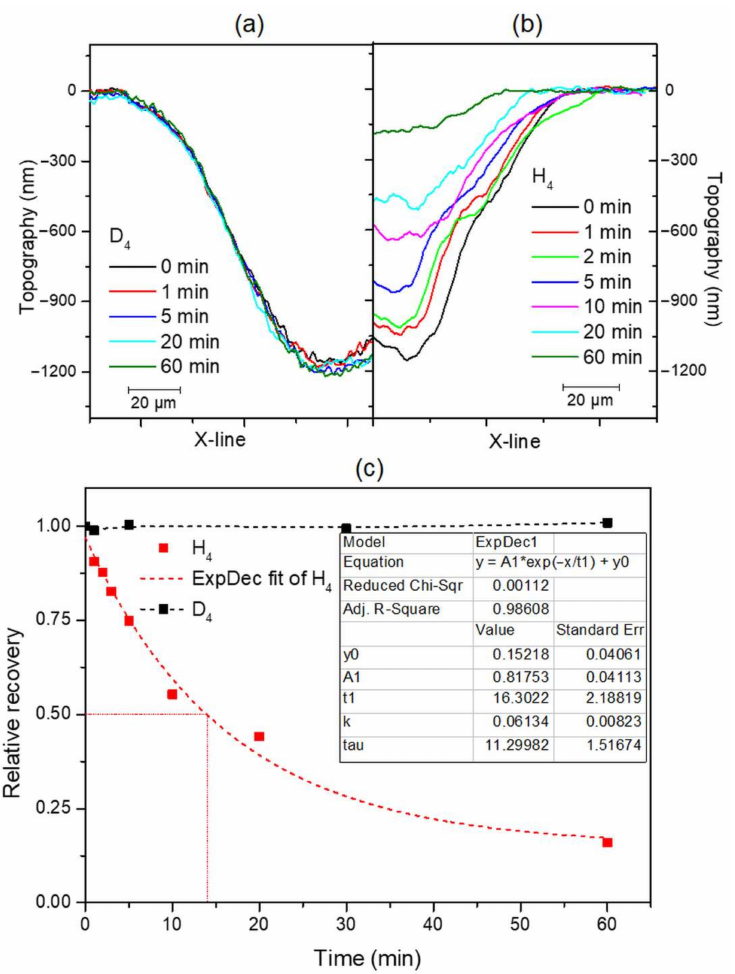
Figure 7. Illustration of the surface self-healing (recovery) effect based on the topography of scratches: ( a ) sample D 4 ; ( b ) sample H 4 ; ( c ) the kinetics of relative recovery for samples D 4 and H 4 . The experi- mental values of recovery kinetics were fitted by the exponential decay function. The measurements were performed at RT and 30 ± 1%